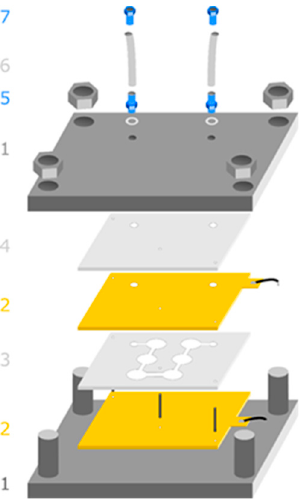
Figure 2. Exploded view of the mold used to apply the electric field during resin curing: six disc samples are produced at a time.